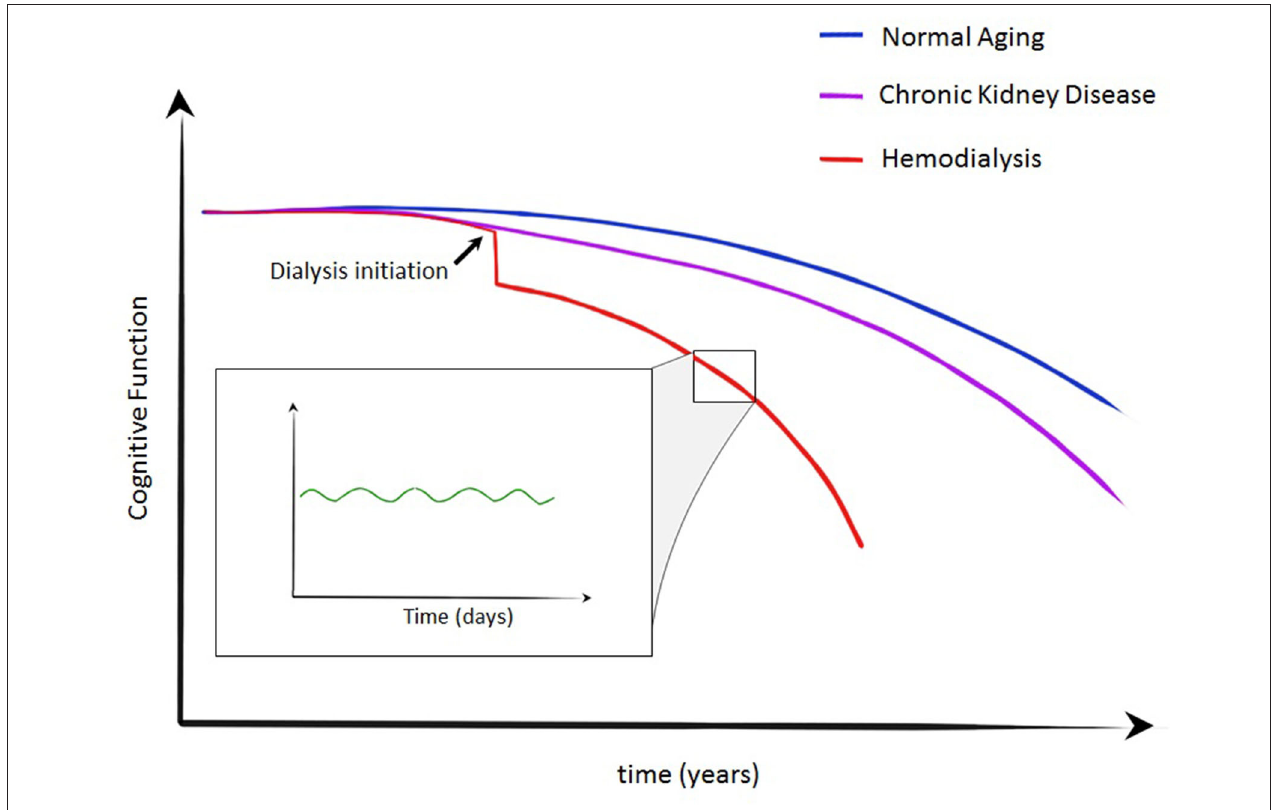
FIGURE 4 | Crude conceptualization of cognitive decline in normal aging, CKD and kidney failure requiring dialysis. A stepwise decline is described at the initiation of dialysis with more rapid decline in cognitive function in those on dialysis. During individual dialysis treatments, transient cognitive decline has been demonstrated—an insult likely to contribute to the trajectory of those on